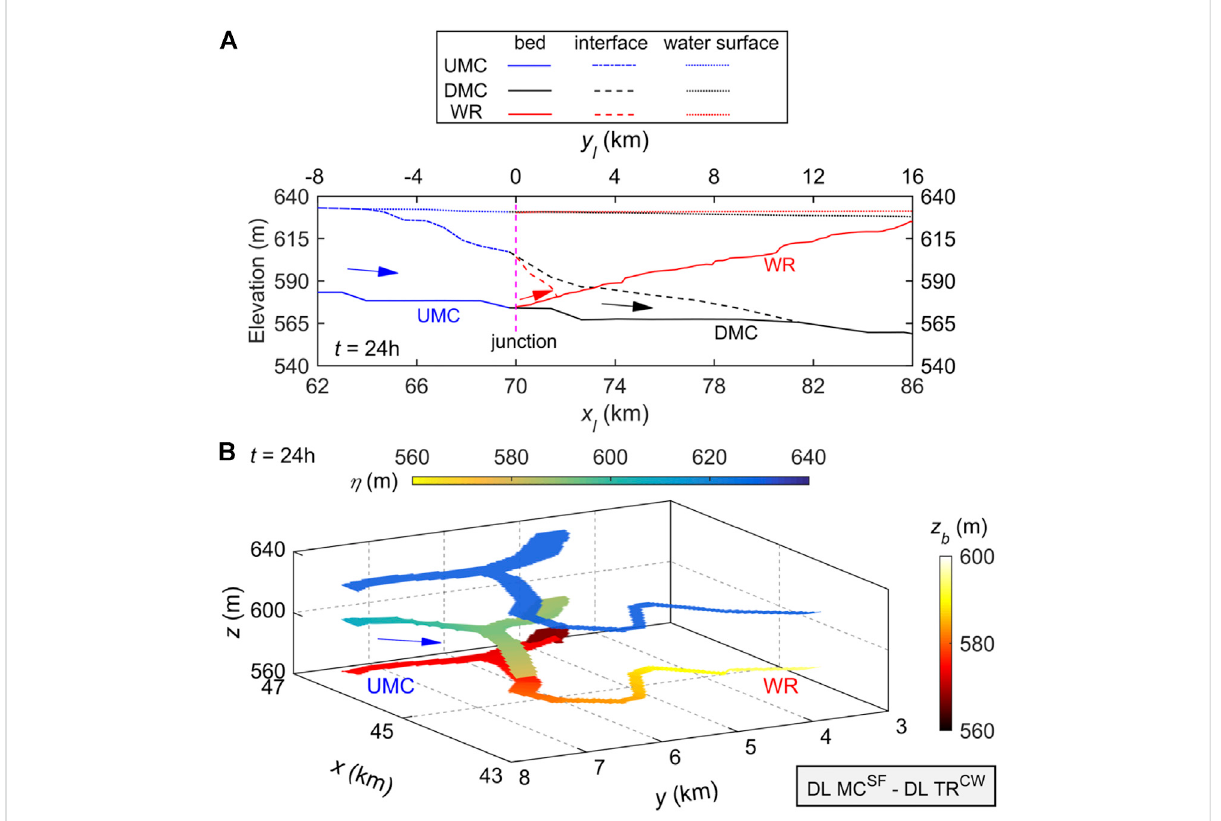
Vertically DL MC SF — DL TR CW within the con fl uence of MC (Yellow River) and WR (Wuding River) at t = 24 h, where UMC and DMC denote upstream and downstream of the MC con fl uence: (A) water surface elevation, interface, and bed pro fi les along the thalweg, and (B) three- dimensional layered fl ow structure.